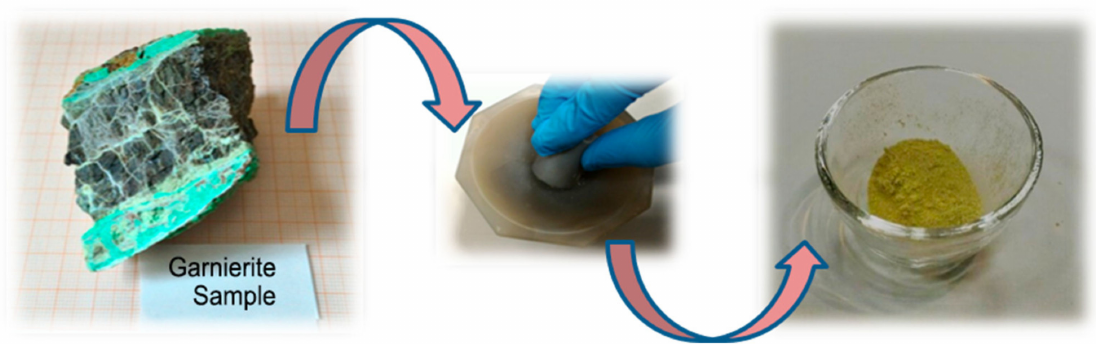
Figure 1. Optical image of the starting garnierite sample (left image); small pieces of this sample were manually ground (central image) to obtain the fine powder used in the thermal treatment (right